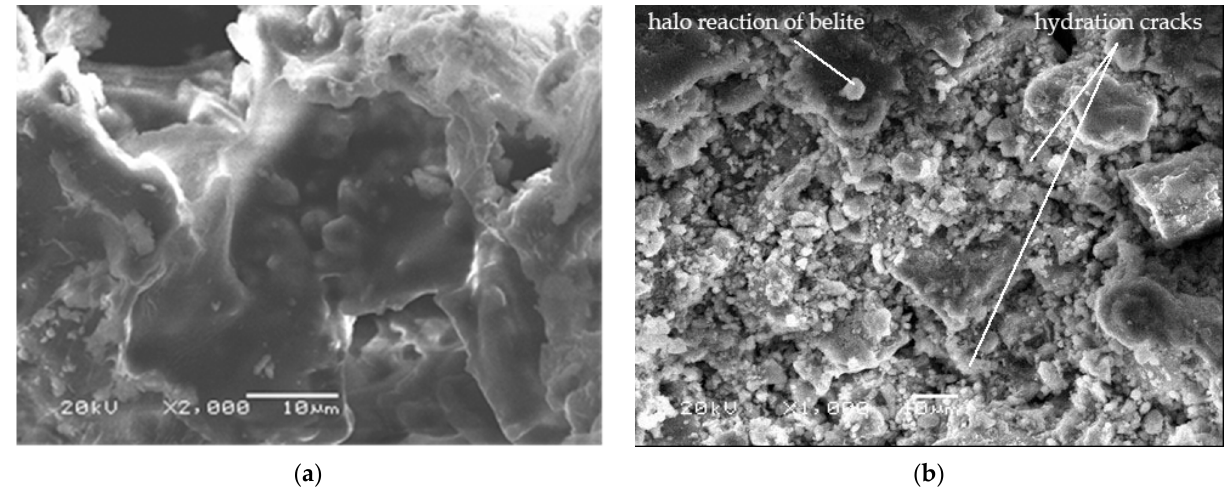
Figure 8. ( a ) Starch gel enveloping cement grains 3 days after hydration and ( b ) cement grains 8 days after hydration.